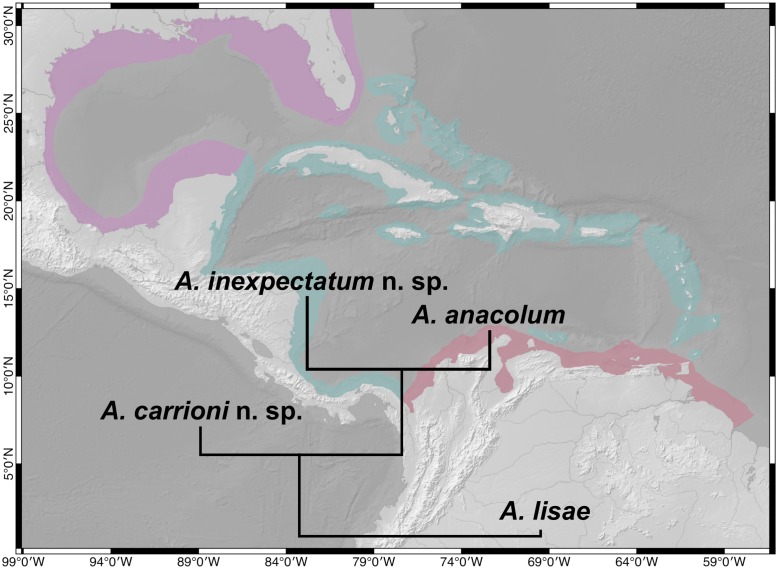
Diversification of Anindobothrium.Colored coast lines of the Great Caribbean represent three major provinces based on patterns of endemism as suggested by Robertson & Cramer [66]: Northern Province—the Gulf of Mexico and southeastern USA [pink]; Central Province—the West Indies, Bermuda and Central America [blue]; and Southern Province—Northern South America (red). [Map raster source by Natural Earth in QGIS Geographic Information System/Open Source Geospatial Foundation].